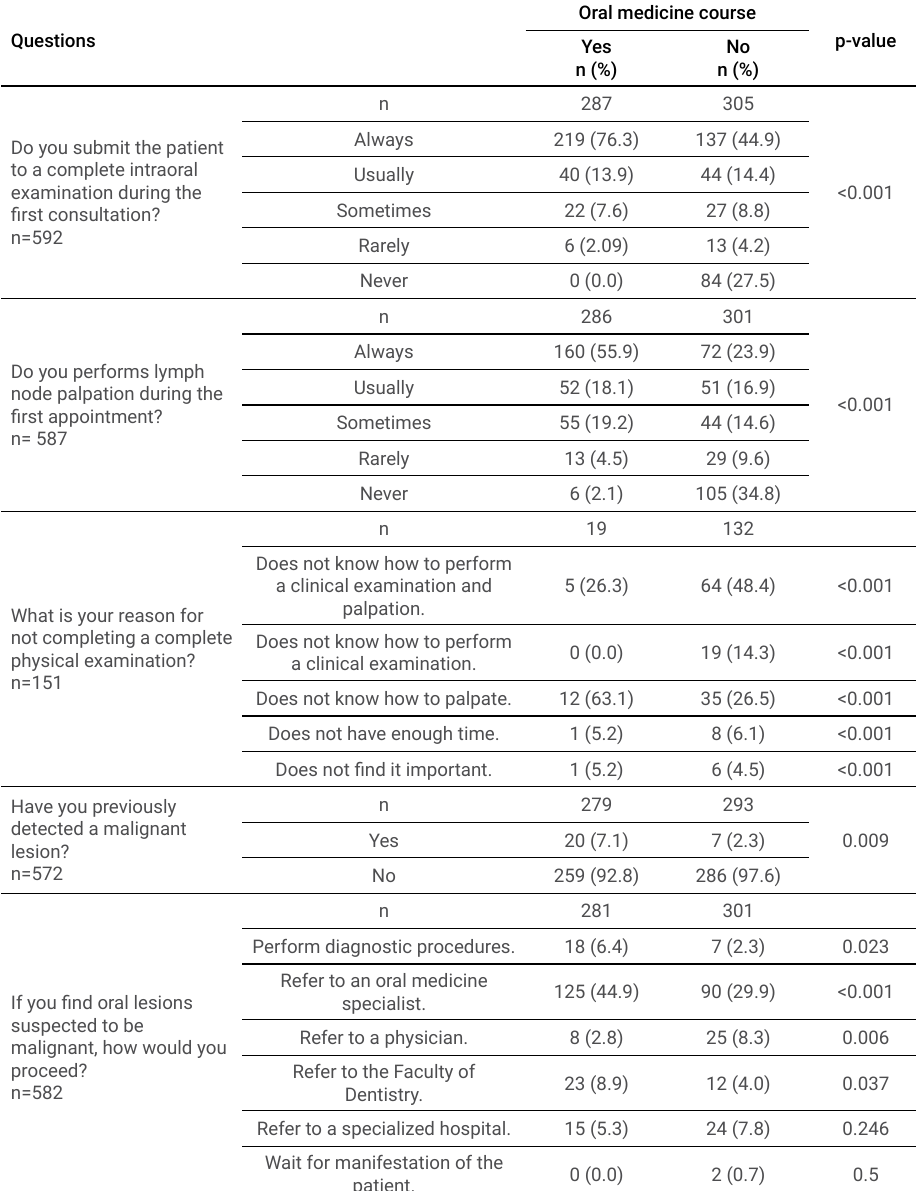
Table 2. Undergraduate dental students’ attitudes regarding oral cancer prevention (N = 646; Paraná,